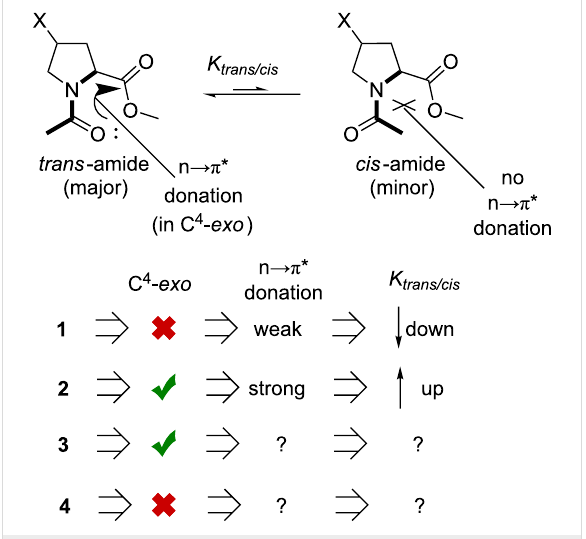
Figure 8: The expectations regarding the amide-bond rotation prefer- ences in 1 – 4 .